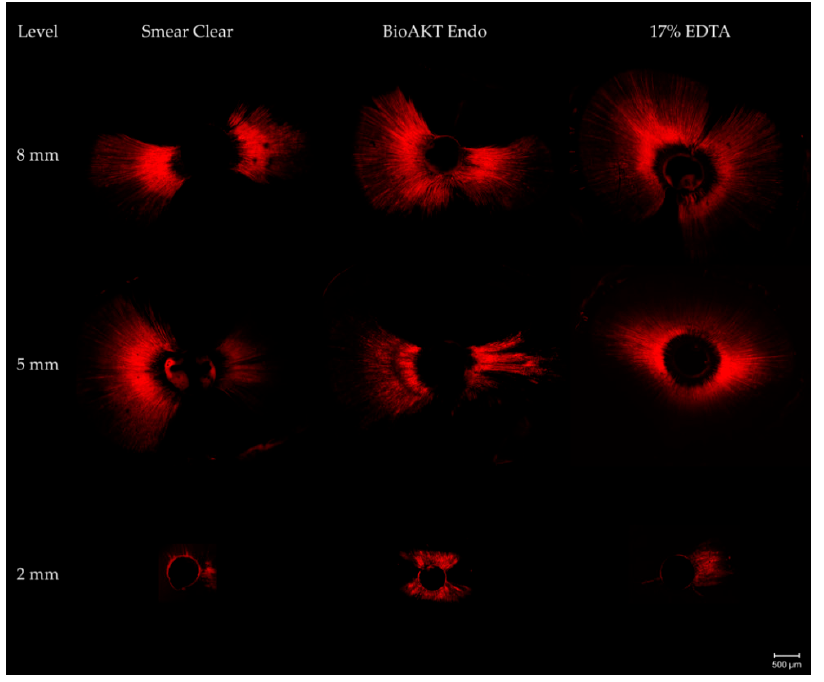
Figure 1. Representative images of the evaluated groups. As for the maximum penetration depth, data are reported in Table 4. At the apical level, the BioAKT Endo group had the highest values compared to the other groups. In particular, it was significantly higher than the EDTA values. Table 4. Maximum penetration of irrigants ( μ m, mean ± s.d.).